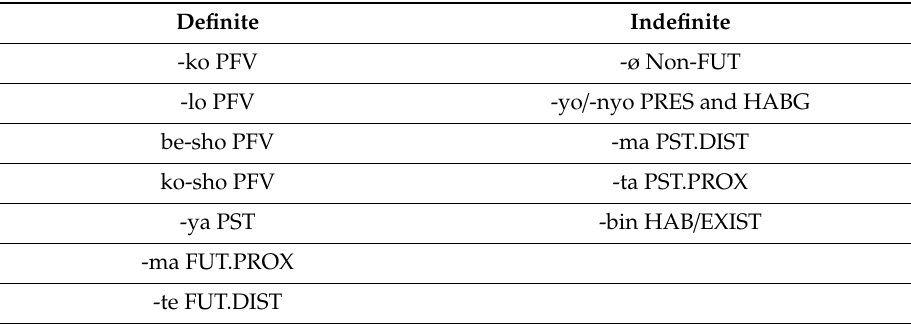
Table 4. Definiteness in Rengma tense-aspect.